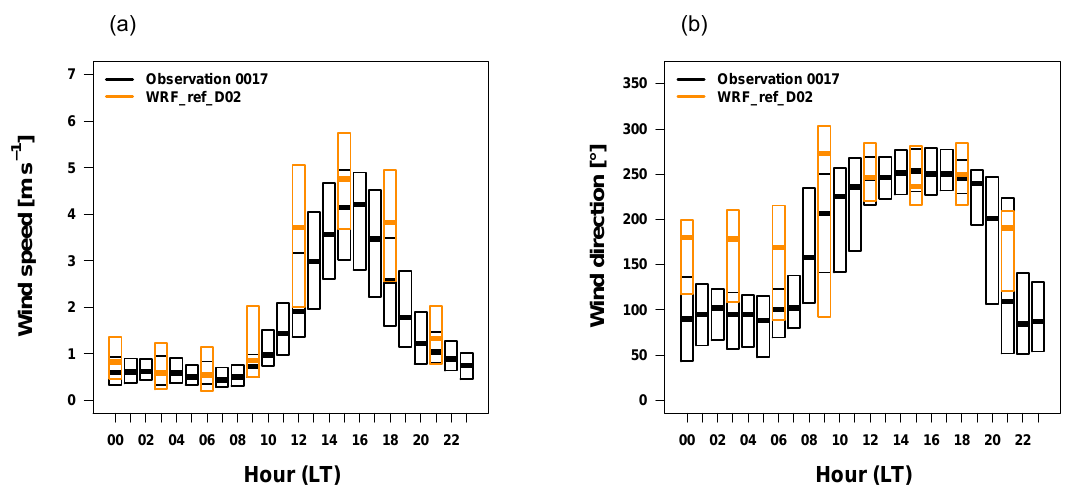
Figure 8. Diurnal cycle of the measured and simulated (WRF_ref_D02) wind speed (ms − 1 ) (a) and wind direction ( ◦ ) (b) for the period of January–June 2013 as a boxplot (showing the median, the upper and lower quantiles) at the Bode station.